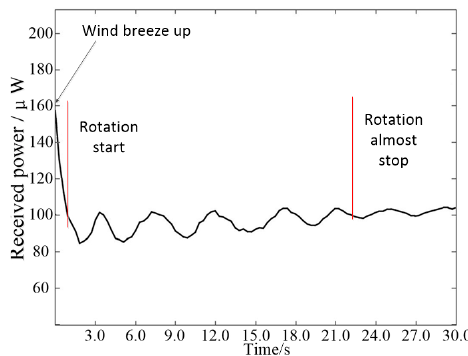
Figure 13. Statistical chart of received energy with the wind.